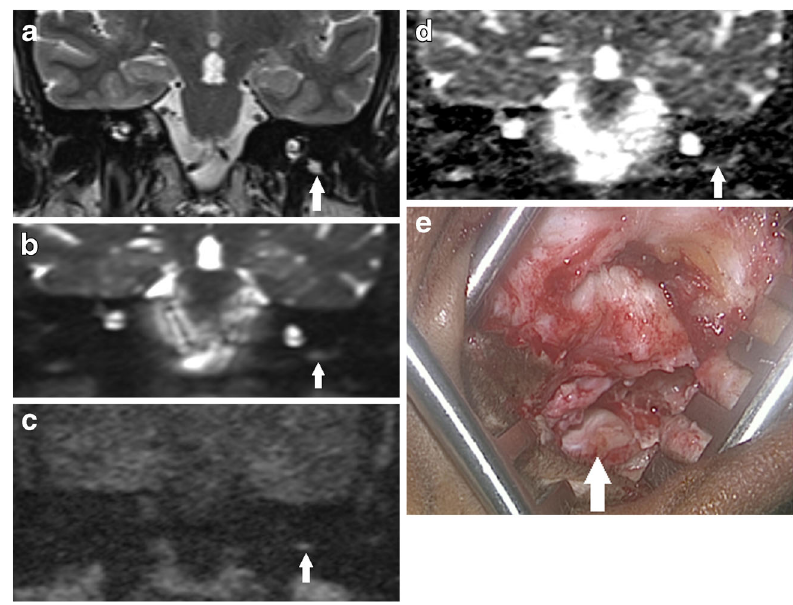
Fig. 11 Indeterminate appearance of residualcholesteatoma: Value of ADC. The coronal a T2 weighted and b b0 DWI images show a small focus of high signal soft tissue at the left hypotympanum, which returns just mildly high signal relative to brain tissue on c the b1000 DWI image, raising the possibility of a residual pearl (similar to Fig. 9a). d The ADC map demonstrates low signal and value compatible with cholesteatoma, thereby increasing observer confidence. e This was later confirmed as a 3 – 4 mm cholesteatoma at the left hypotympanum on second-look